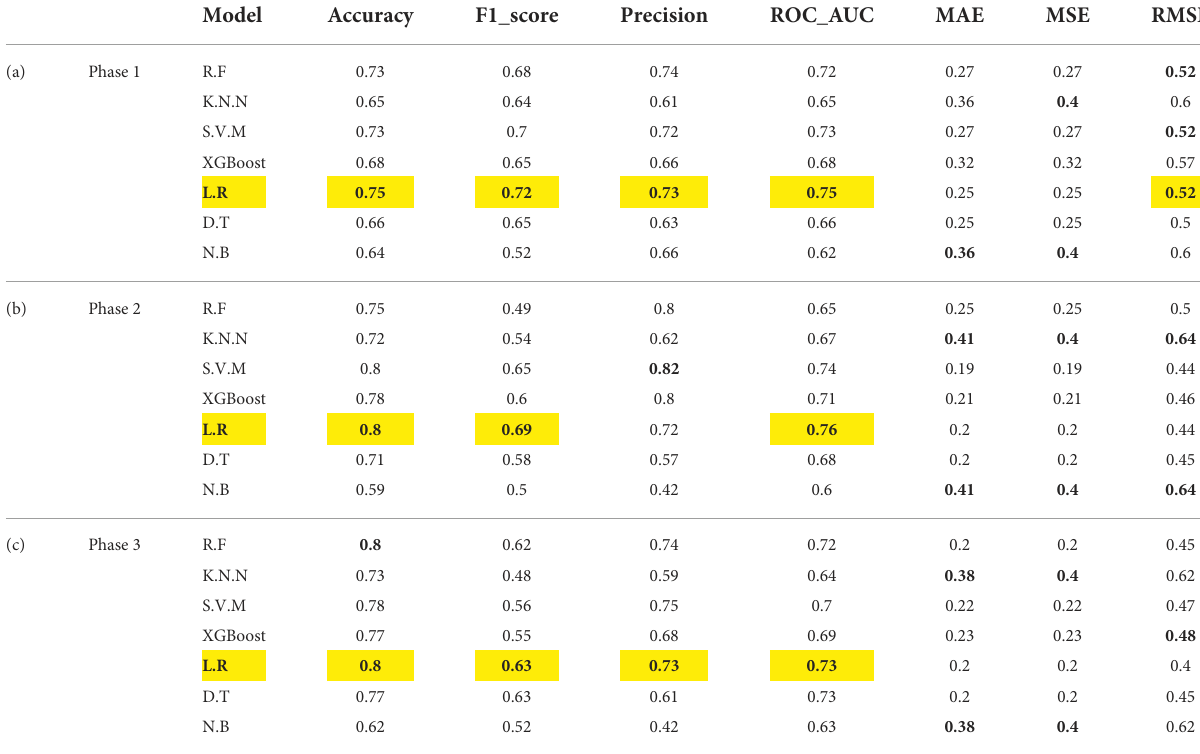
TABLE 2 The performance of machine learning methods for different phases.